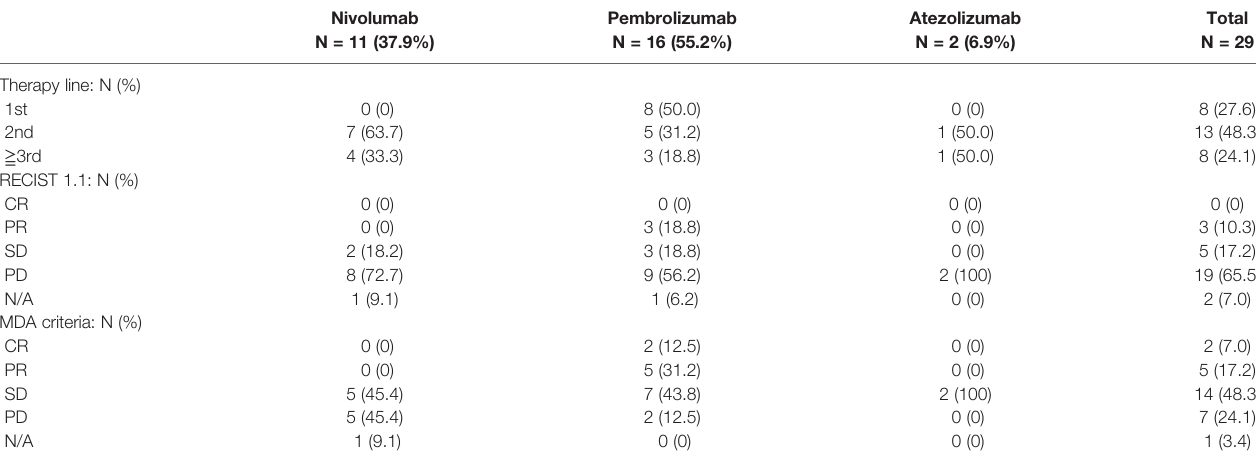
TABLE 2 | Therapeutic effect of ICIs on primary lung lesions and bone metastases. Nivolumab Pembrolizumab Atezolizumab